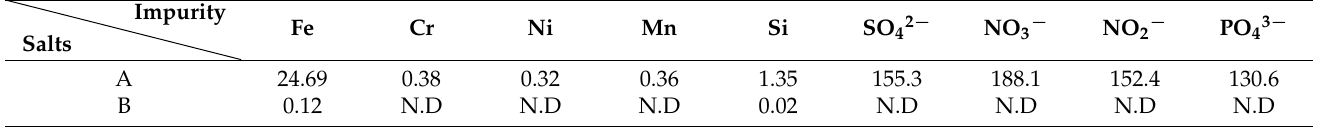
Table 1. The main impurities in salts A and B pre-corrosion tests (mg/kg).